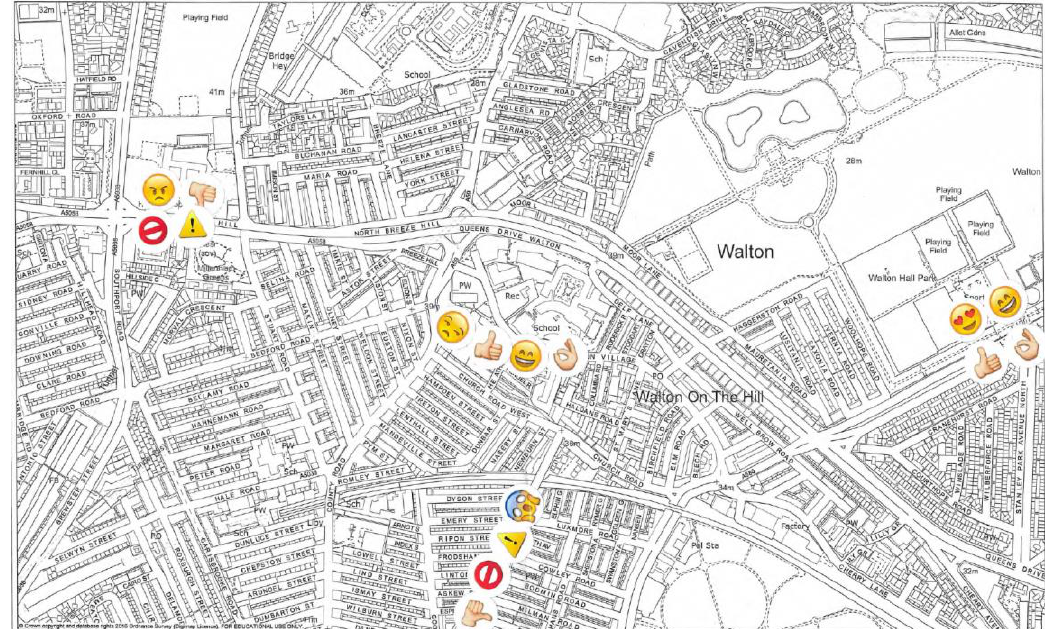
Figure 3. Example A3 map of local area (not to scale). Here a 13 year-old, female participant has selected four features that she regards as being significant for local community formations (including the school she attends, in the centre for the map). She has used several emoticon stickers to represent her range of thoughts, feelings or experiences, and so on, about